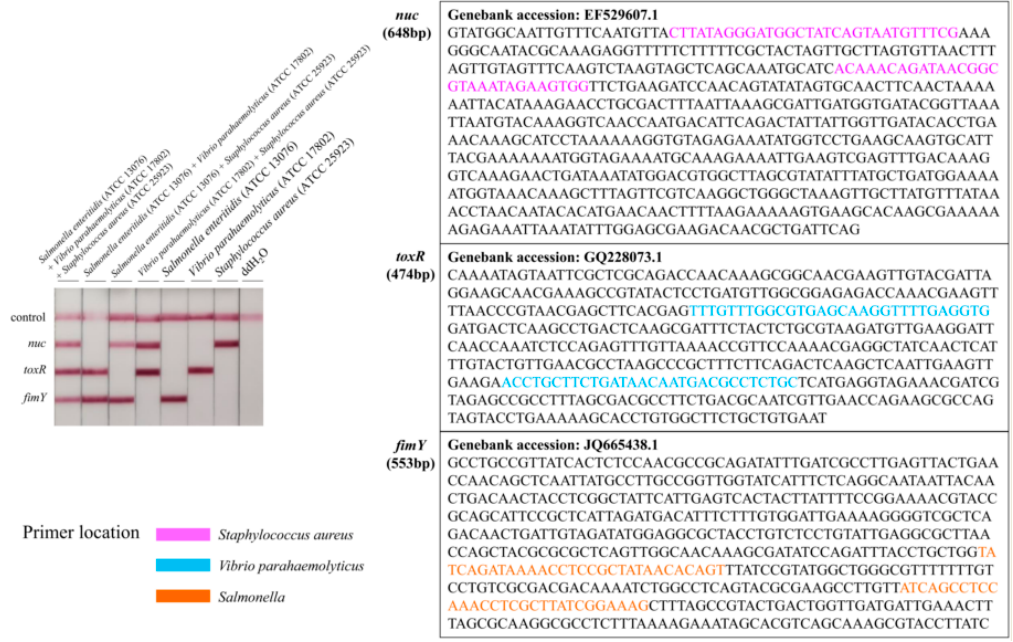
Figure 4. Specificity between the nuc gene for Staphylococcus aureus , toxR gene for Vibrio parahaemolyticus , and fimY gene for Salmonella enterica and the primer location in genes.